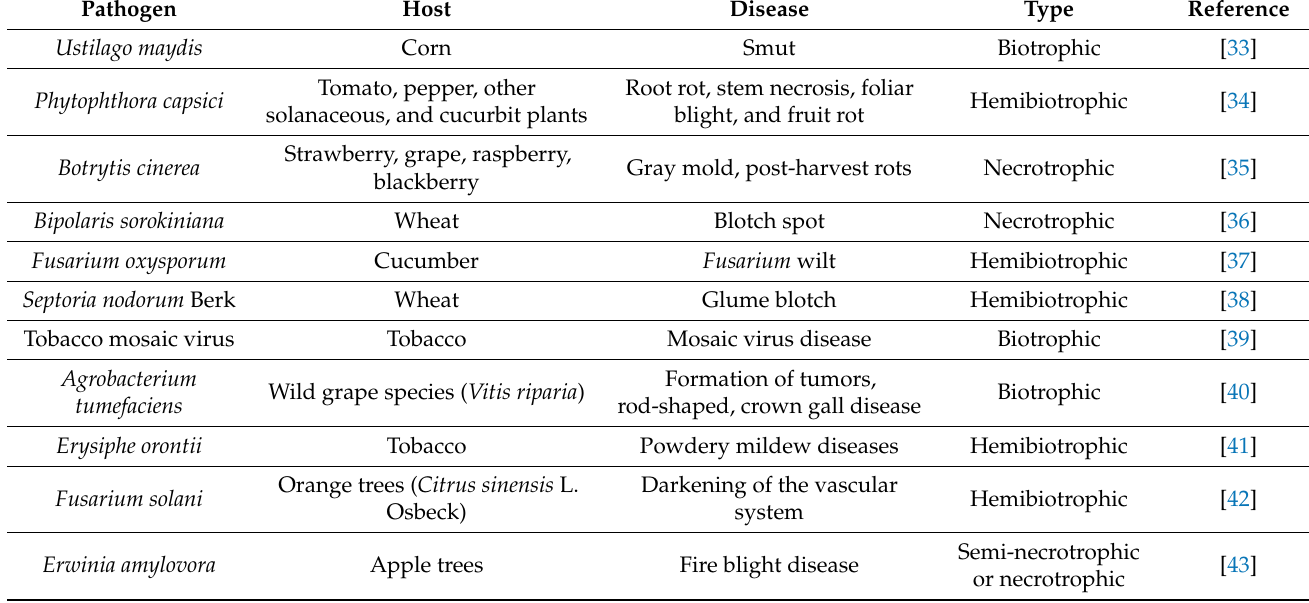
Table 1. Interactions between pathogens and host